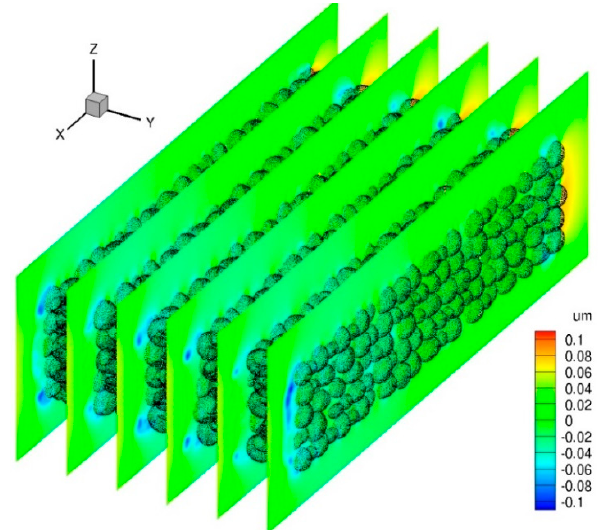
Figure 6. Preliminary mean velocity ( um ) results in the streamwise direction (positive x-direction) from Hydro3D [20] using the structured nodes from the Matlab script. Key Hydro3D parameters: Domain: x = 0.6 m, y = 0.4 m, z = 0.2 m; Mesh: dx , dy , dz = 0.001 m; U bulk = 0.289 m/s; Slope = 0.001; phi depth = 0.16 m.